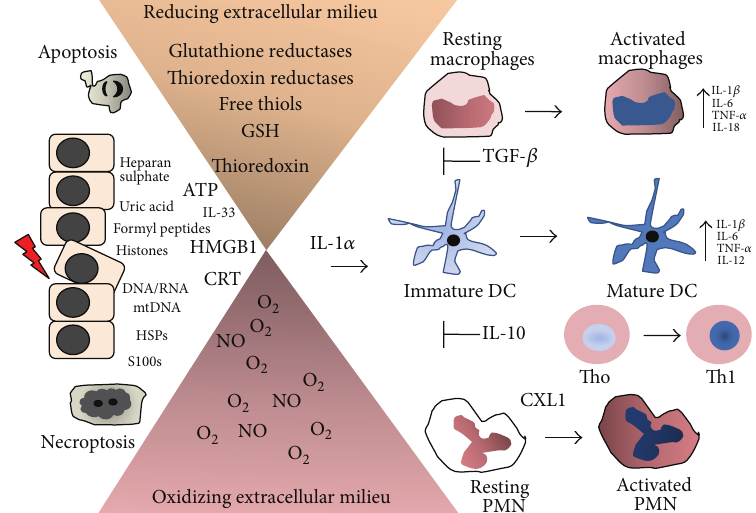
Figure 5: Inflammatory response to the cell death-associated factors release by apoptotic and necrotic cells and their control by the redox inflammatory microenvironment. Dying and dead cells release a wide array of molecules, including ATP, CTR, HMGB1, nuclear DNA, and IL-1 𝛼 thatexertmultiplefunctionsintheinnateimmuneresponse.IL-1 𝛼 ismostpotentdangerfactor.Thesecellsalsoreleasenonproteinthiols and thiol-regulating enzymes and highly diffusible prooxidant reactive oxygen and nitrogen species, which create an oxidizing and reducing gradientintheinextracellularmilieu.Thepro-andanti-inflammatoryactivityofDAMPs,alarmins,cytokines,andlipidmediatorsareaffected by oxidation/reduction reactions in certain components of their structures. For instance, if all cysteines in the HMGB1 protein are reduced, it binds to CXCR4 and acts as chemoattractant. HMGB1 linked with disulfide binds to TLR-4 and induces proinflammatory cytokines, whereas further cysteine oxidation to sulfonates by ROS abrogates both activities. The constitutively higher ROS levels in macrophages were shown to inhibit procaspase-1 activation by reversible oxidation of cysteine residues on the zymogen. Similarly, IL-1 𝛽 and IL-18 are prone of oxidation, causing their inactivation. Thus, the outcome of inflammatory response depends on the balance of oxidizing and reducing factors confined within injured cells that are released in the extracellular milieu. Inflammation resolution occurs with efficient macrophage clearance of the apoptotic cells. Apoptotic cells emit a small number of DAMPs, alarmins, and cytokines as well as proteases, as compared with apoptotic cells. Thus, necrotic cells sustain a long inflammatory response throughout the process of cellular resolution. Futures studies focusing on molecular targets involved in the critical steps of necrotic cell death program may help us to find new therapeutics to control the deleterious inflammatory